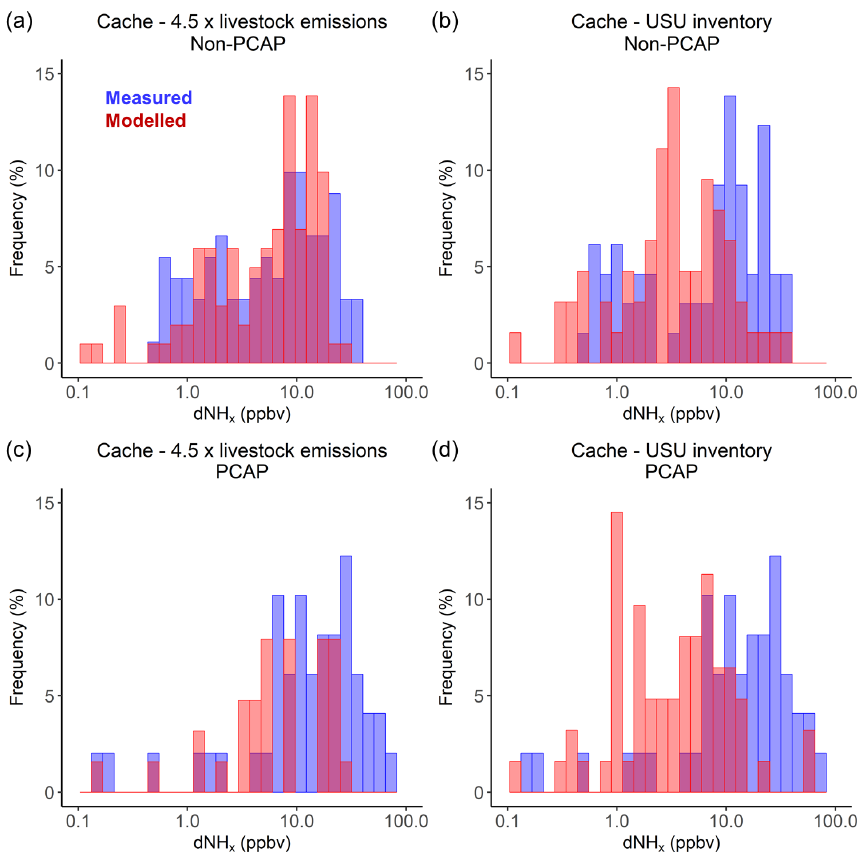
Figure 7. Frequency distribution of measured (blue) and modelled (red) NH x enhancements (dNH x ) for Cache Valley, using enhanced livestock emissions by a factor of 4.5 and the USU emission inventory for (a, b) non-PCAP and (c, d) PCAP conditions.